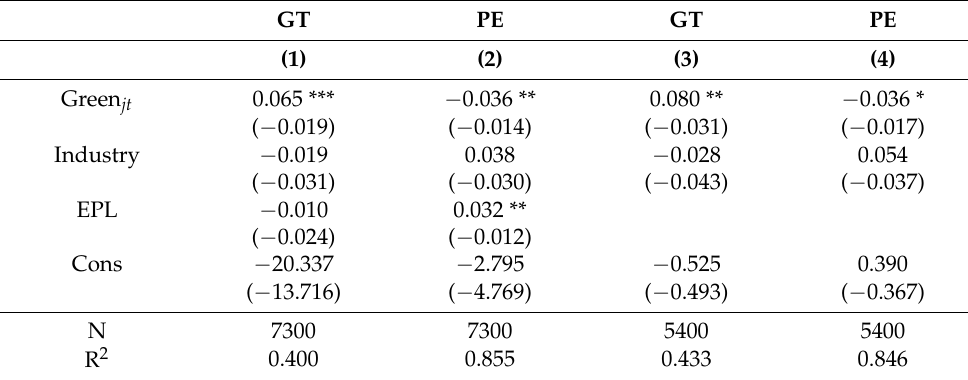
Table 7. Exclude the impact of other